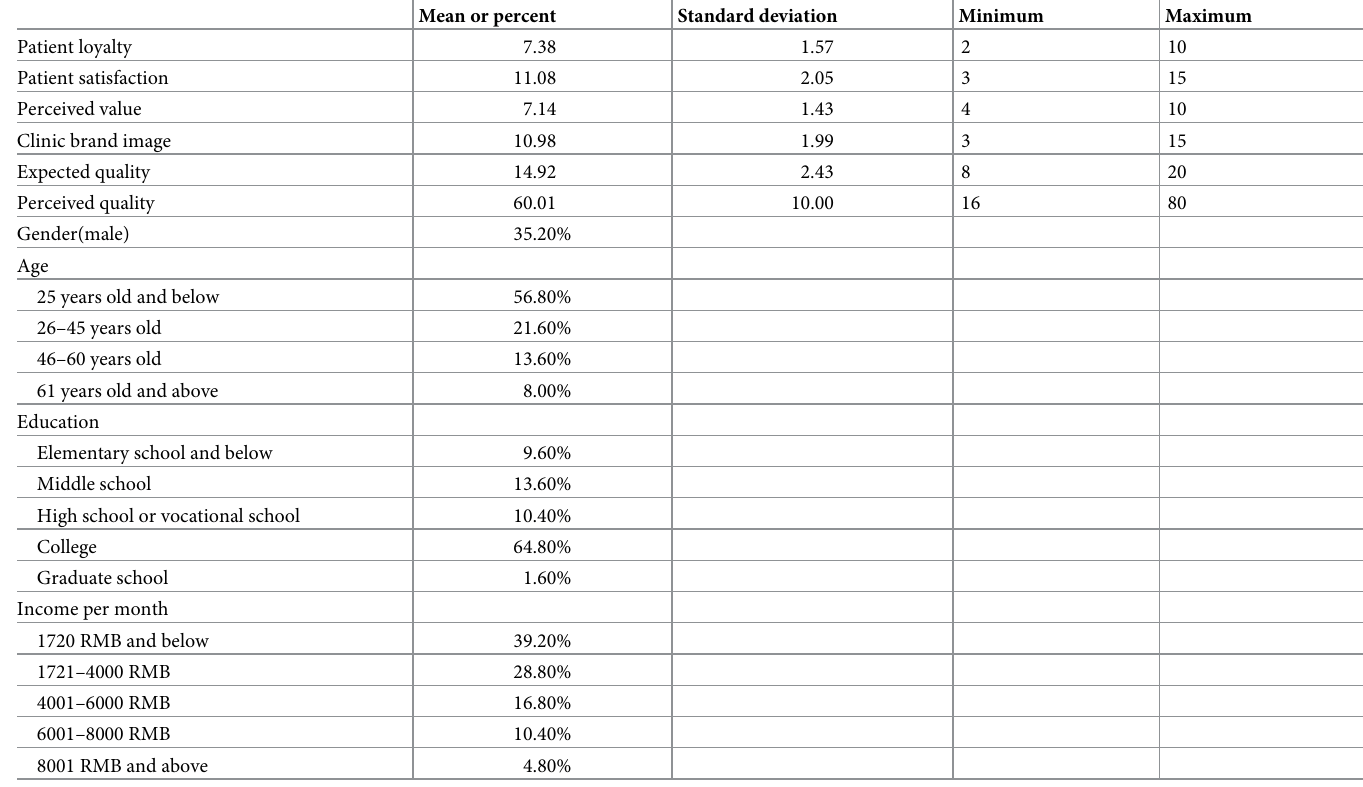
Table 2. Sample description (n =